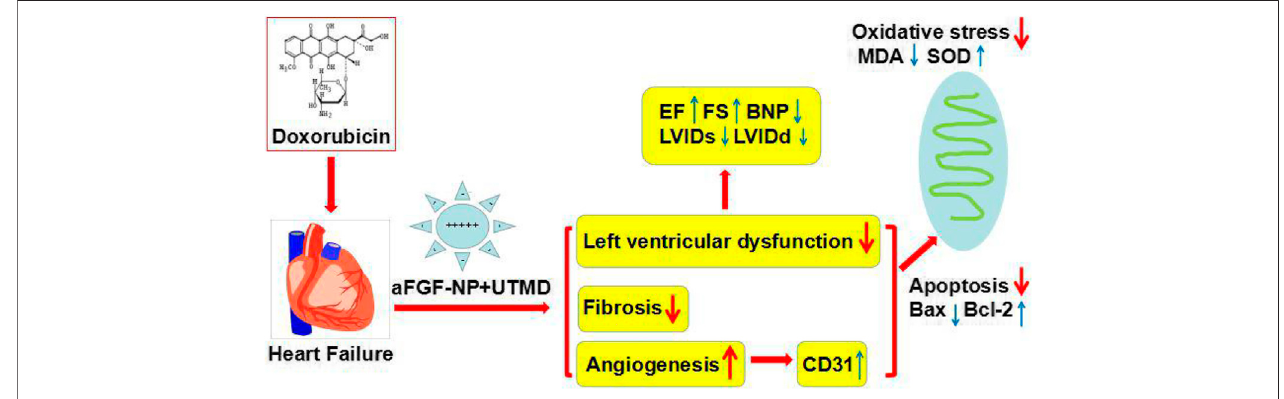
FIGURE7| ThetherapeuticmechanismoftheaFGFtargetedmediatedbynovelnanoparticlesmicrobubblecomplexcombinedwithUTMDinhibitionofmyocardial oxidative stress, fi brosis, apoptosis, and promotion of cardiac angiogenesis in doxorubicin induced – heart failure rats.